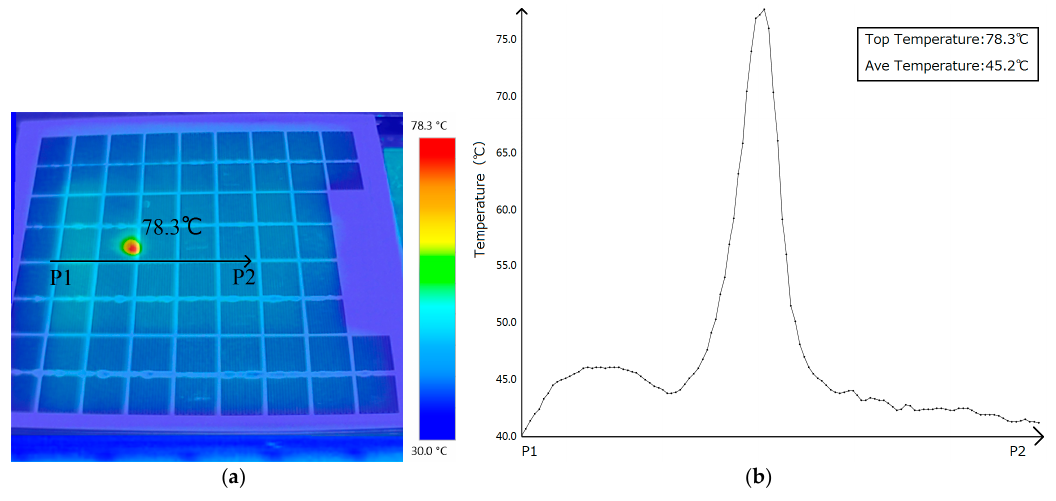
Figure 1. Infrared (IR) image of a hot-spot cell: ( a ) Hot-spot in a photovoltaic (PV) module caused by crystal defects. The operating temperature at the hot-spot is 78.3 °C versus 45 °C of the rest of the module, which represents a temperature difference of 33.3 °C; ( b ) Temperature distribution of the hot-spot from P1 to P2, enormous power dissipation occurring in a relatively small area results in hot-spots, which in turn leads to destructive effects, such as cell or glass cracking, melting of solder, or degradation of the solar cell.